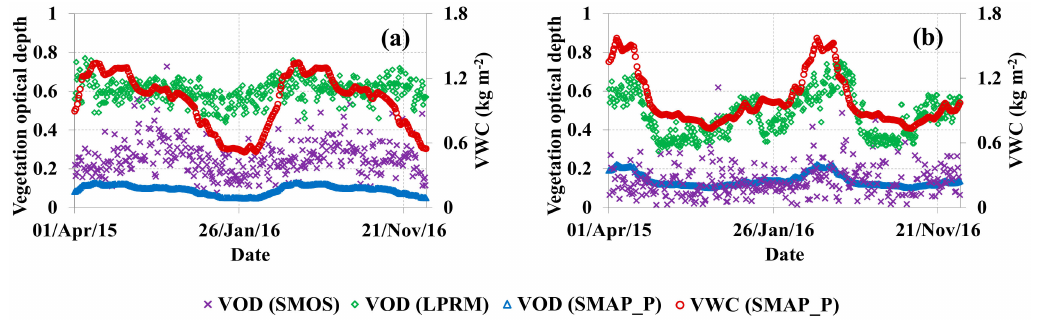
Figure 8. Temporal evolution of satellite-estimated vegetation optical depth (VOD) and vegetation water content (VWC) for the ( a ) LWW and ( b ) REMEDHUS network